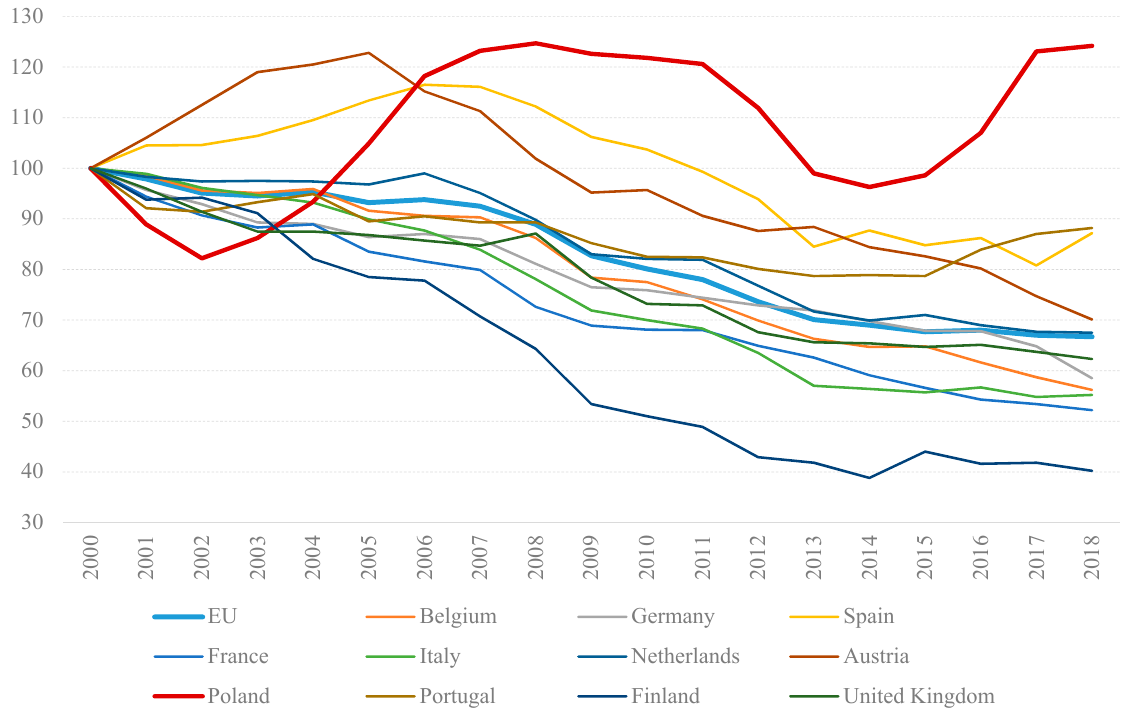
Figure 8. Pollutant emissions from transport (year 2000 = 100%) Source: European Environment Agency (EEA), Eurostat, accessed on 5 January 2021.